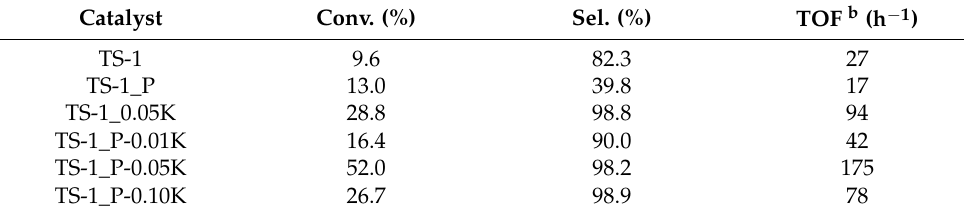
Table 2. Catalytic epoxidation of cyclopentene with H 2 O 2 over various TS-1 zeolites a . Catalyst Conv.